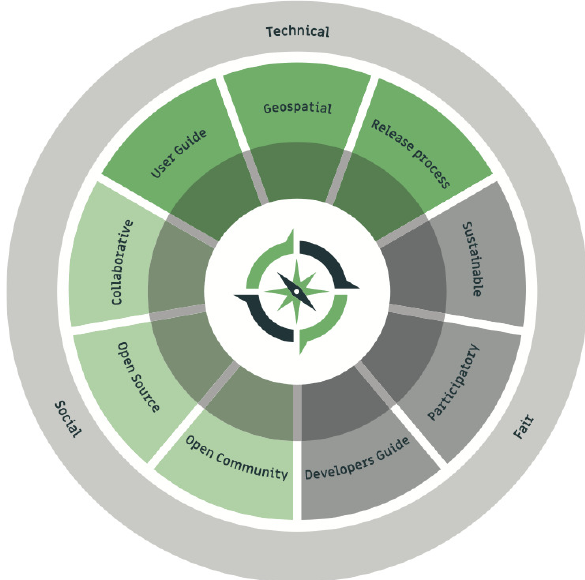
Figure 2. Diagram of the core topics assessed by the OSGeo incubation process (Source: OSGeo.org)